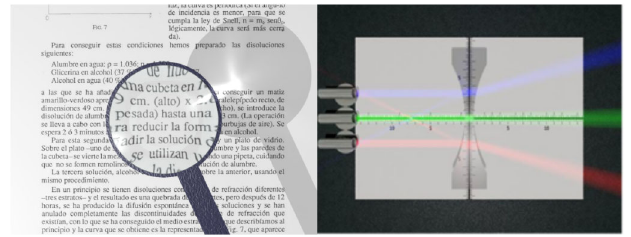
4 (color online). Left: Hyper-realistic simulation of the behavior of a converging lens over a printed text. Right: Hyper- realistic simulation of the behavior of the effects of three incident rays parallel to the optical axis of a diverging